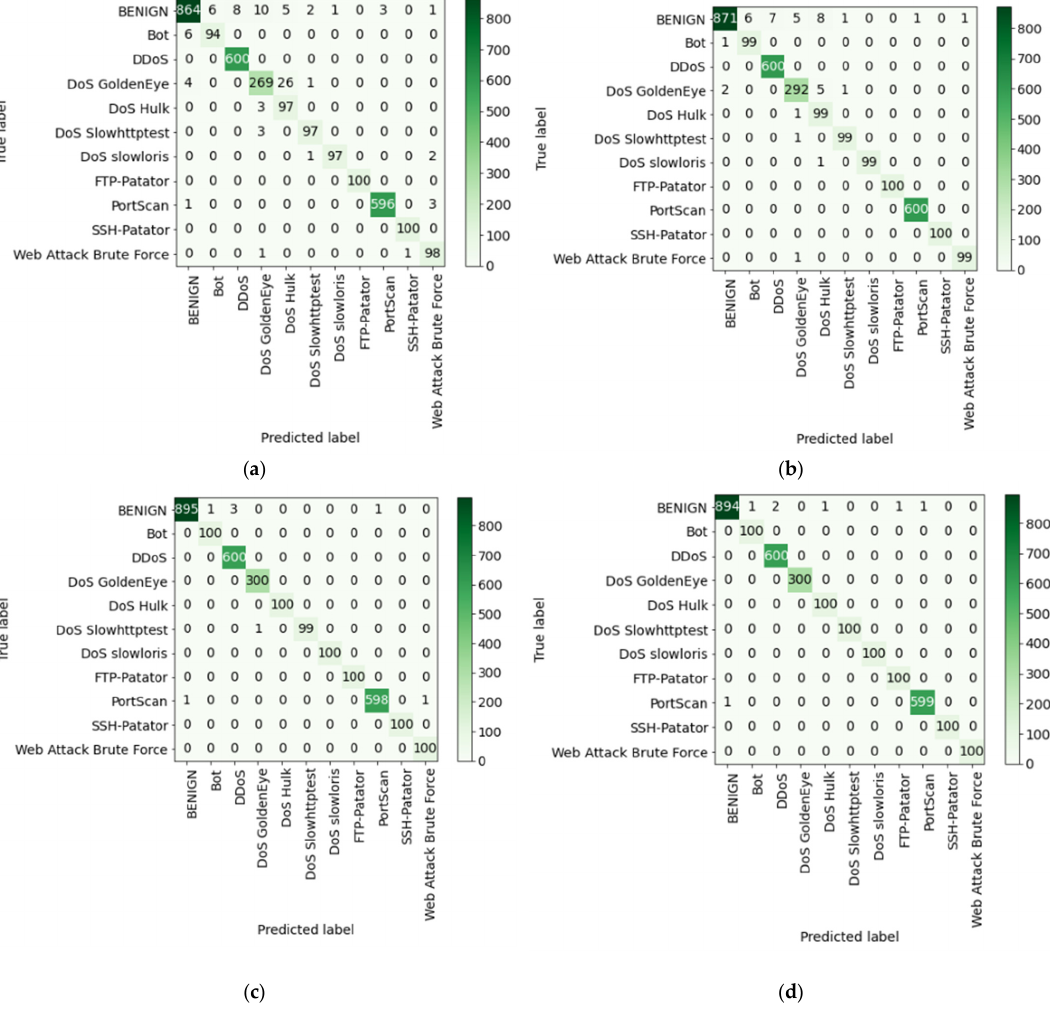
Figure 6. Confusion matrix for each NIDS using CIC-IDS2017. ( a ) CNN; ( b ) DNN; ( c ) HAST-I; ( d ) Proposed.